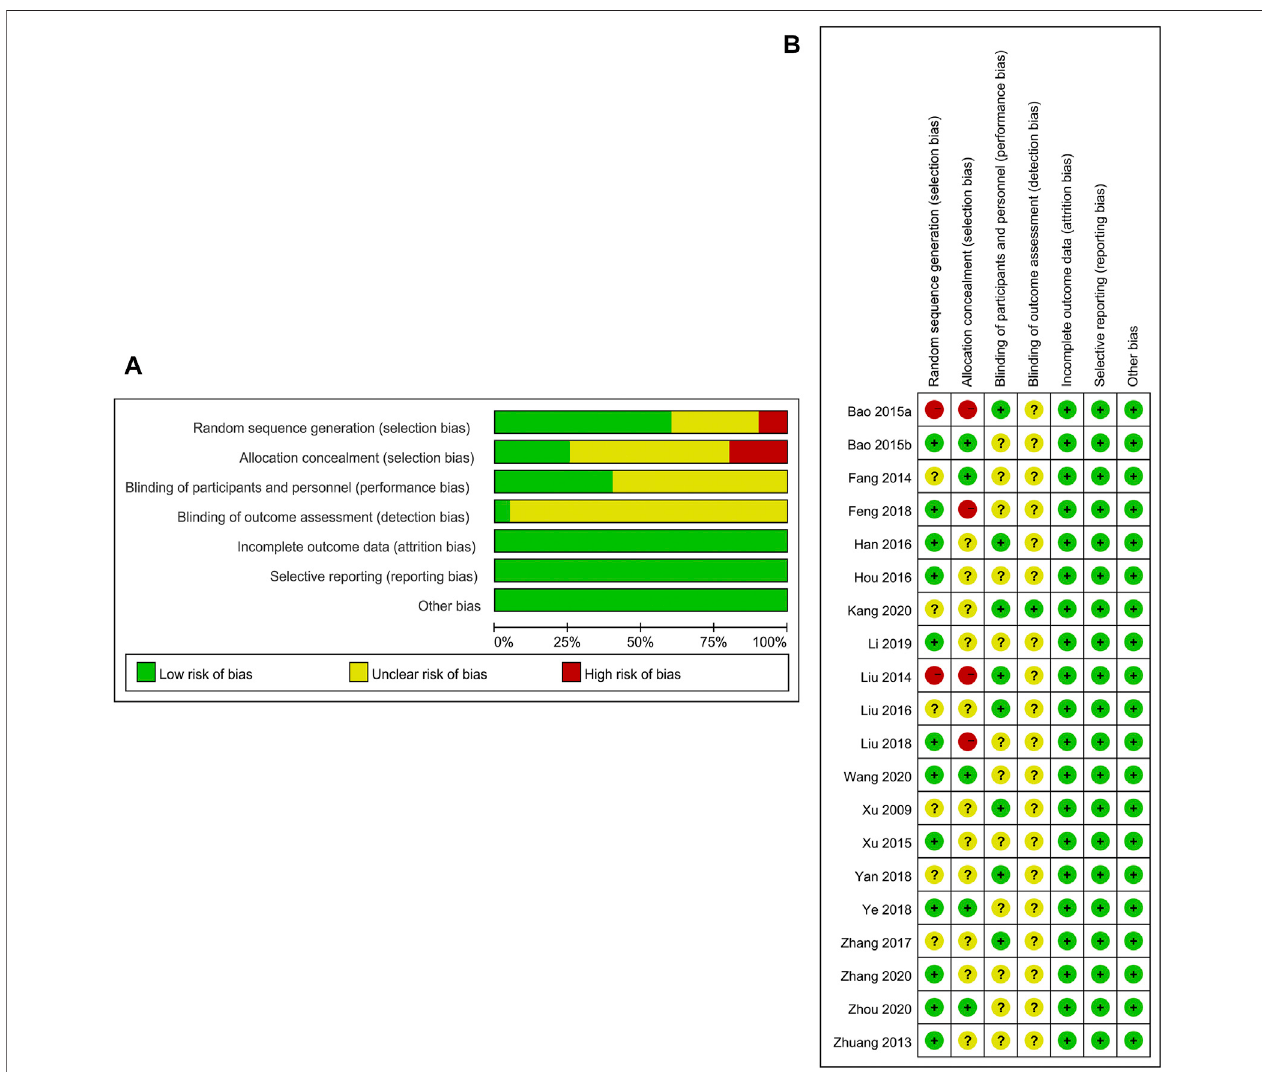
FIGURE 2 | (A) Risk of bias graph: review authors ’ judgements about each risk of bias item presented as percentages across all included studies. (B) Risk of bias summary: review authors ’ judgements about each risk of bias item for each included study.